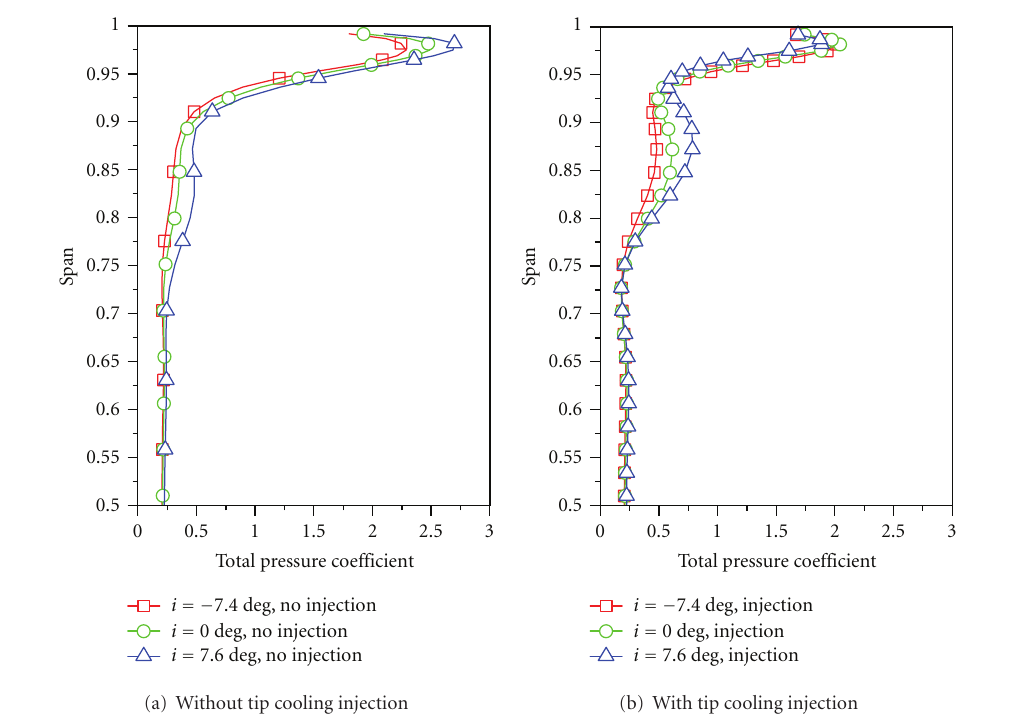
Figure 6: Pitchwise mass-averaged total pressure loss at cascade